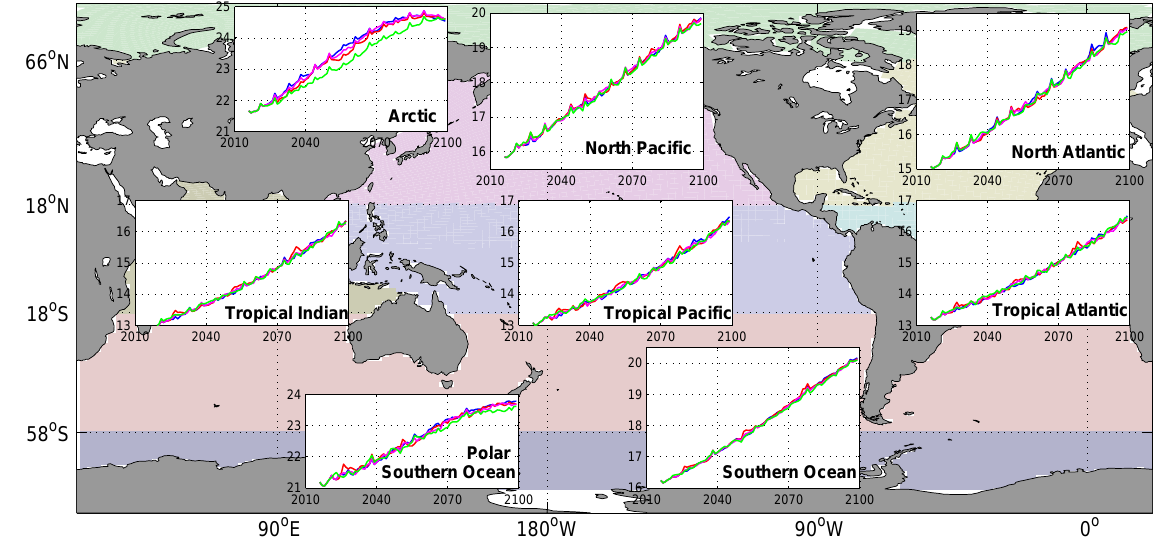
Fig. 9. Similar to Fig. 8 for the Revelle